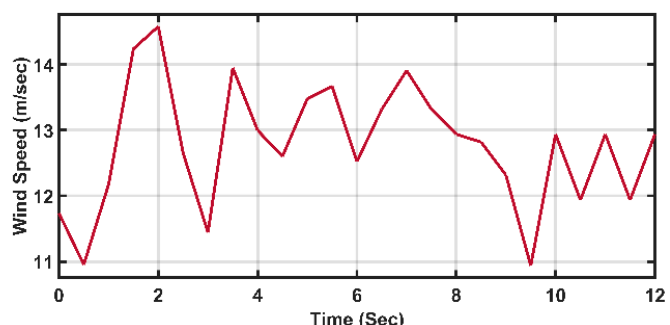
Figure 15. Wind-speed profile of normal second case.